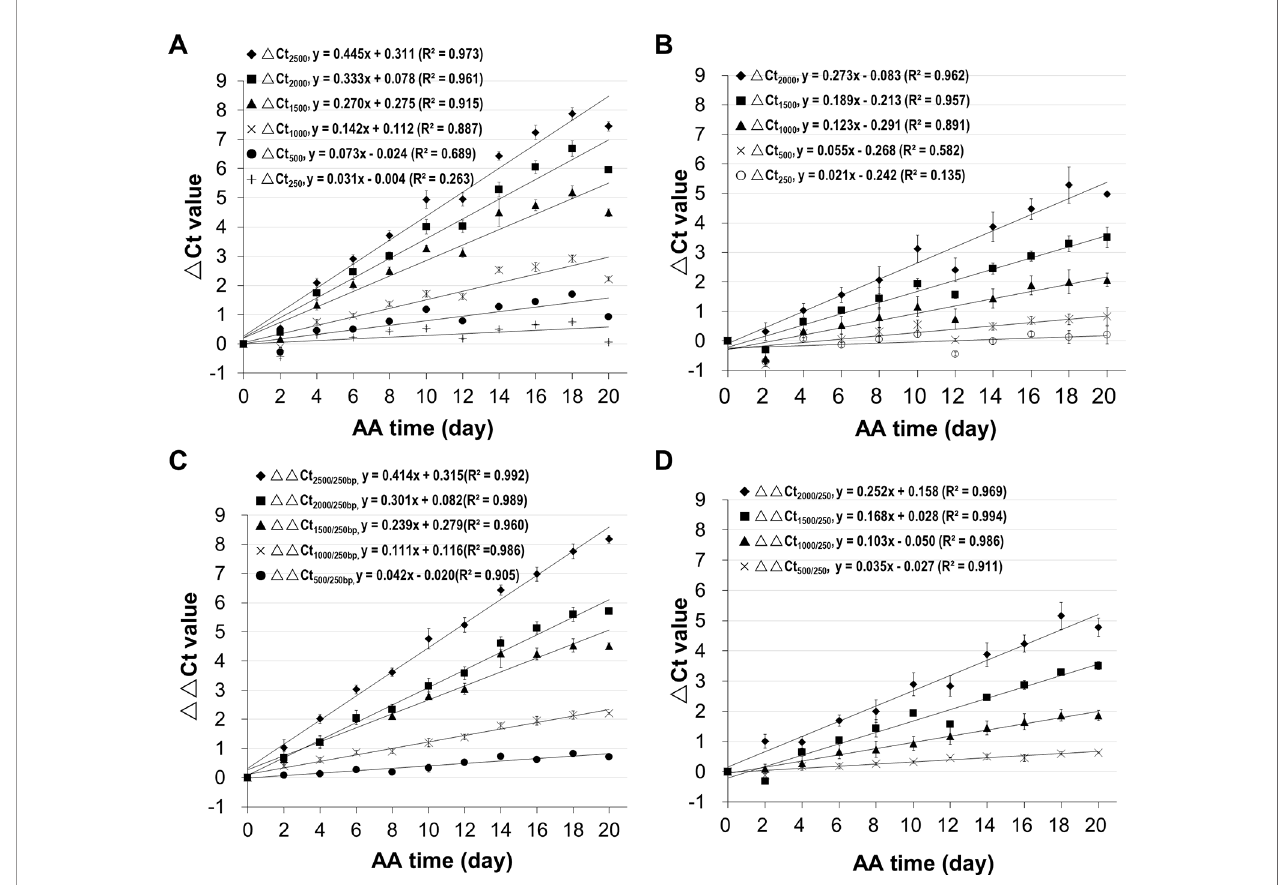
FIGURE 4 | Correlation of mRNA degradation with seed aging time analyzed using different cDNA fragment lengths of two genes. cDNAs of control and arti fi cially aged (AA) seeds for the indicated aging time (days) were used. Different fragments of the gene B16 or B20 were used. D Ct values are based on three technical repeats. (A) Correlation between D Ct values for six different fragments of B16 and aging time. The subscript after D Ct indicates the cDNA fragment length (as D Ct2,500 indicates the D Ct is for the 2,500bp fragment). (B) Correlation between D Ct values for fi ve different fragments of B20 and aging time. (C) Correlation between normalized D Ct values for six different fragments of B16 and aging time. The normalized D Ct or DD Ct2,000/250bp = D Ct2,000bp − D Ct250bp. (D) Correlation between normalized D Ct values of different fragments of B20 and aging time. Linear regression functions were calculated with Excel 2010 and all have a P <0.01 (except for the 250bp fragment of B16 and